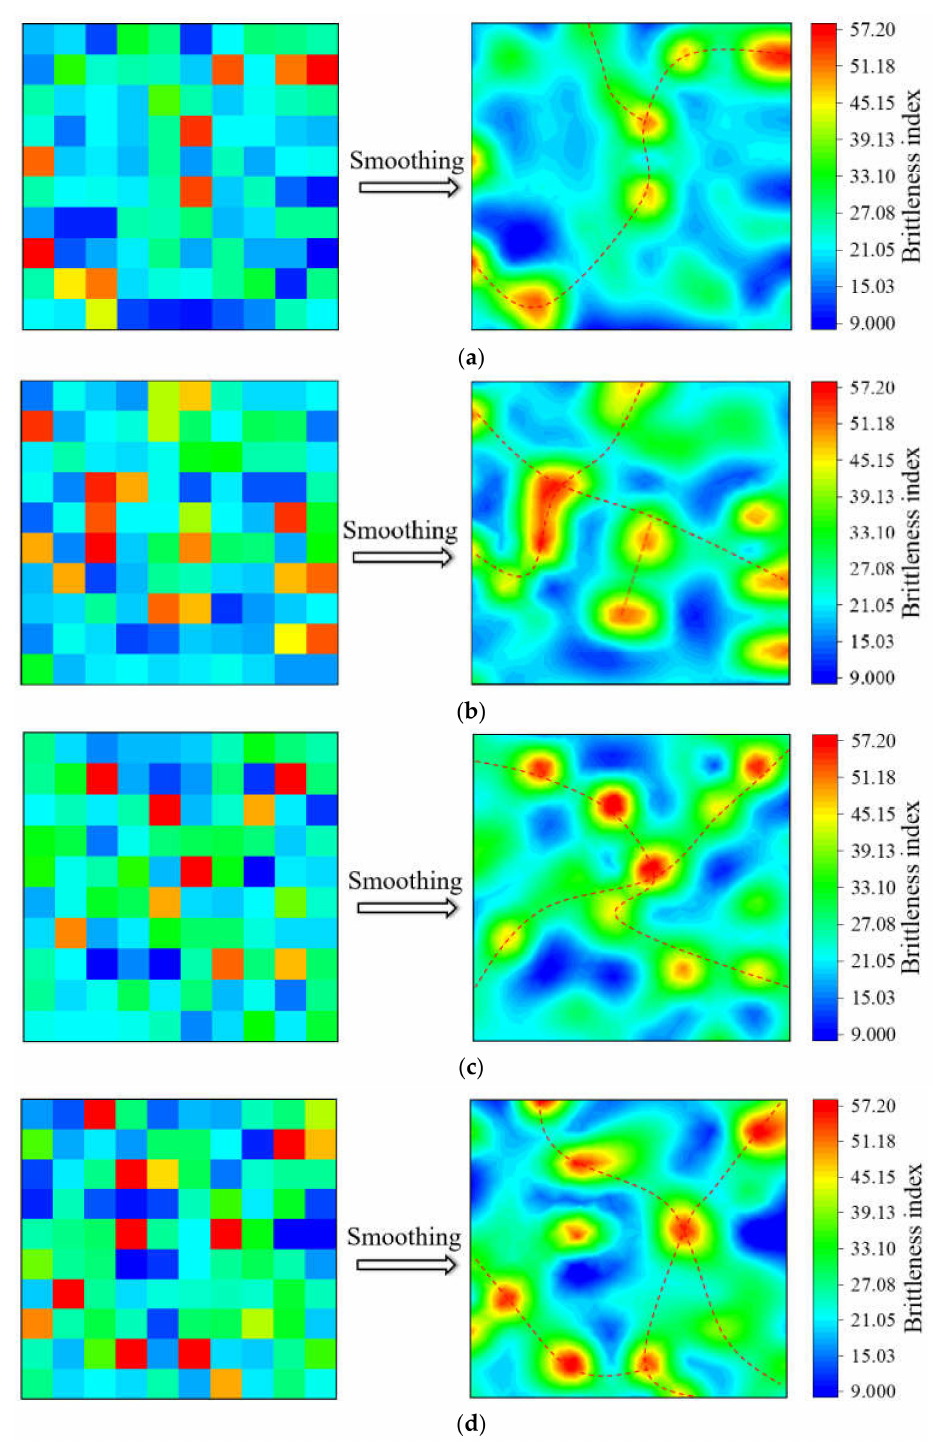
Figure 12. Friability surface distribution: ( a ) nanoindentation grid 1, ( b ) nanoindentation grid 2, ( c ) nanoindentation grid 3, ( d ) nanoindentation grid 4. The red dashed lines in Figure 12 are connec- tions between highly brittle regions that form crack propagation